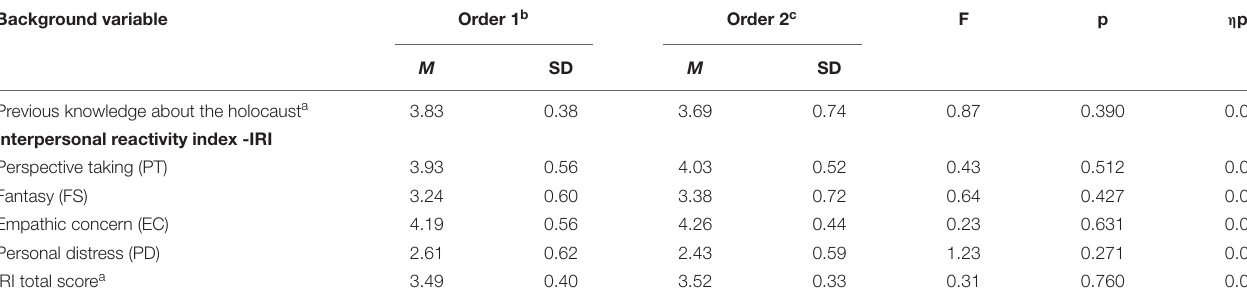
TABLE 1 | Mean, SD and F -values of the background variables by group.